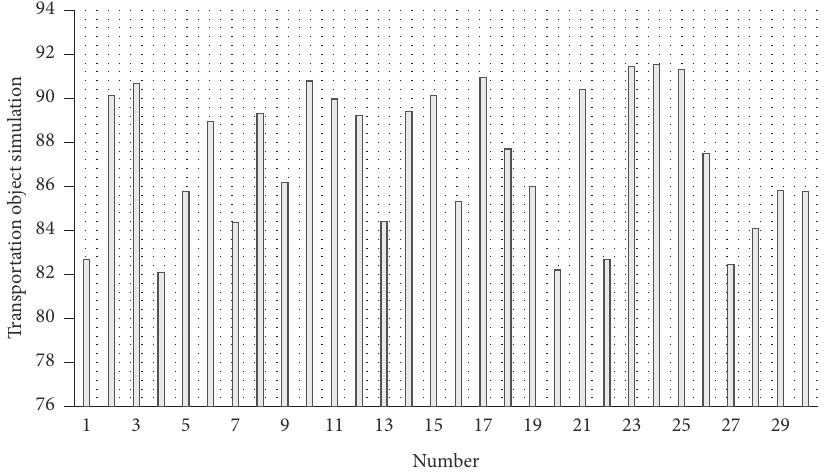
Figure 11: Logistics route simulation.